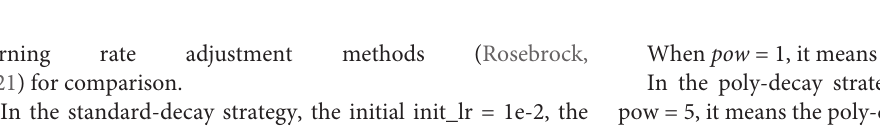
FIGURE 9 | Top-5 results of some cultivars. (A) is test images, (B) is Top-5 results, and the possibility from left to right gradually reduced. The text below the picture means the corresponding flower type and petal type for each cultivar.